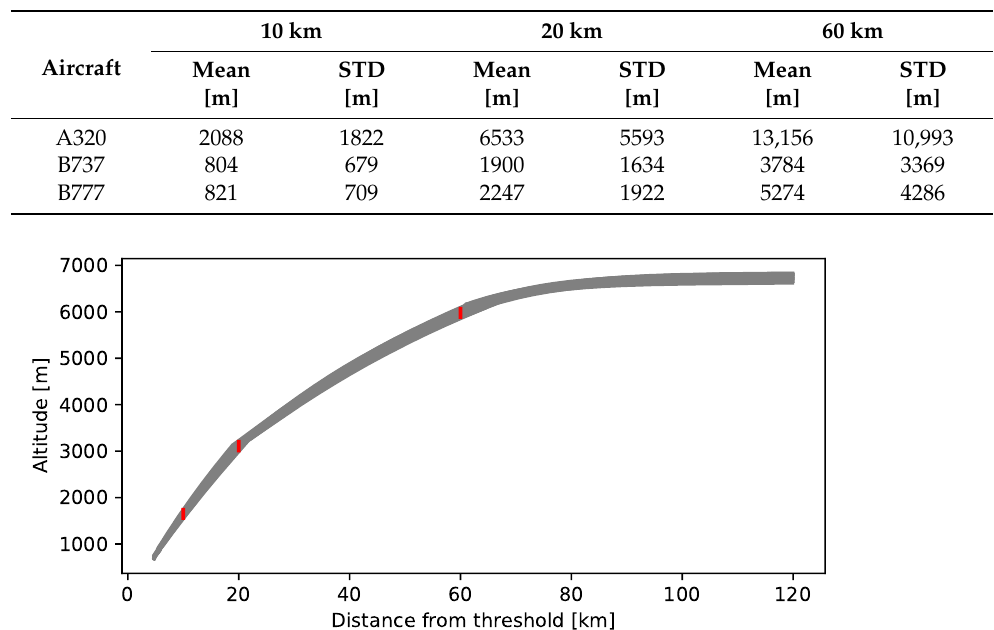
Table 1. Difference in gate width due to wind at 10, 20, and 60 km along-track distance from runway threshold for several aircraft configurations and all freely optimized flights.